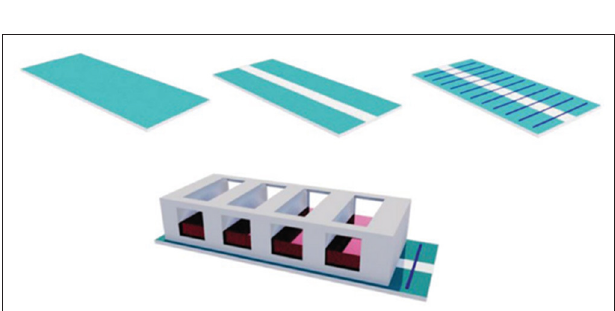
F-actin staining was also observable in the cells coated with PEDOT as early as 1 h after the experiment.